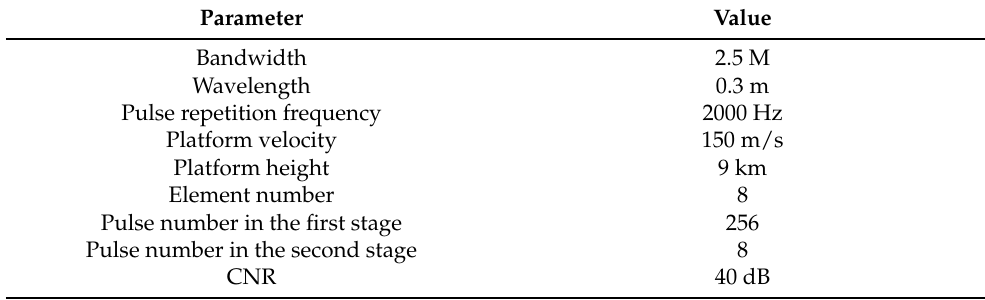
Table 1. Radar system